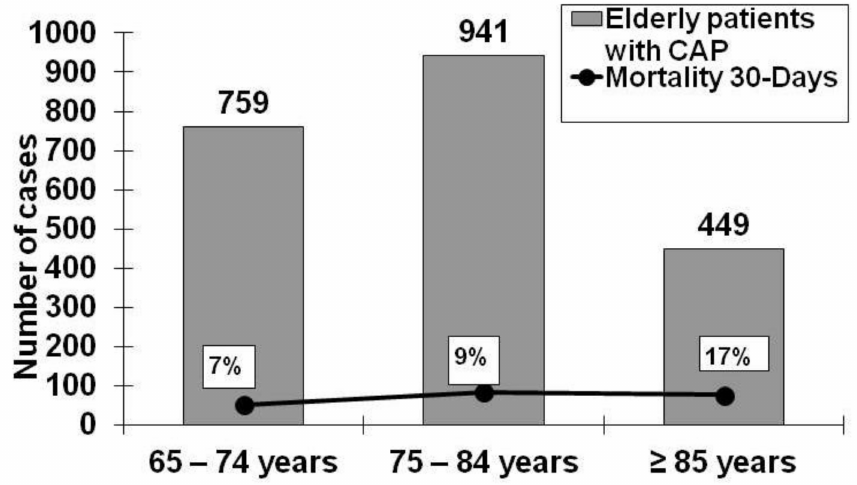
Figure 2. Community Acquired Pneumonia (CAP) by age and percentage of mortality